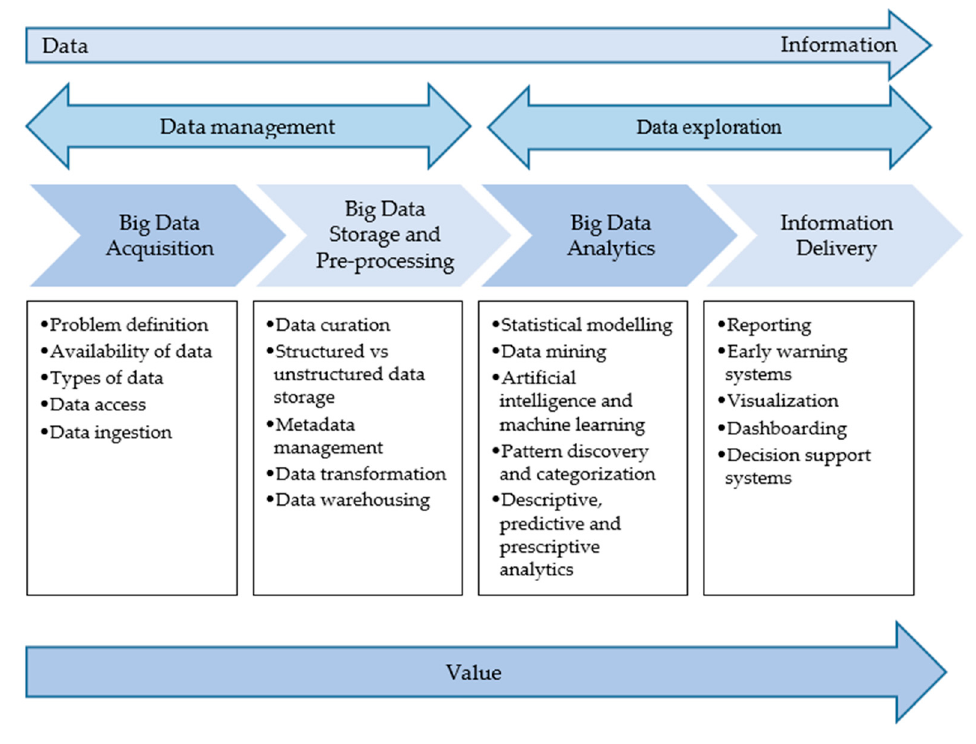
Figure 2. Big data analytics value chain (adapted from [98,99]).